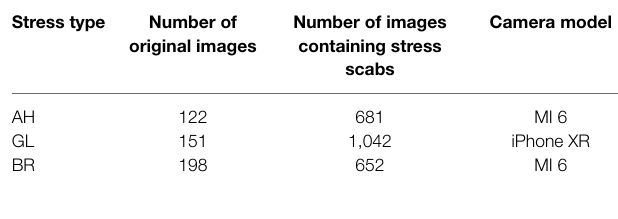
TABLE 1 | The RGB image information regarding tea plant stresses.